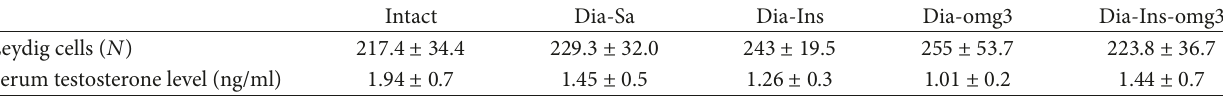
Table 1: Serum testosterone level and the number of Leydig cells were determined in the intact, diabetic-saline (Dia-Sa), diabetic-insulin (Dia-Ins), diabetic-omega3 (Dia-omg3), and diabetic-insulin-omega3 (Dia-Ins-omg3) groups, 35 days after the onset of DM. No statistically significant difference was noted among the